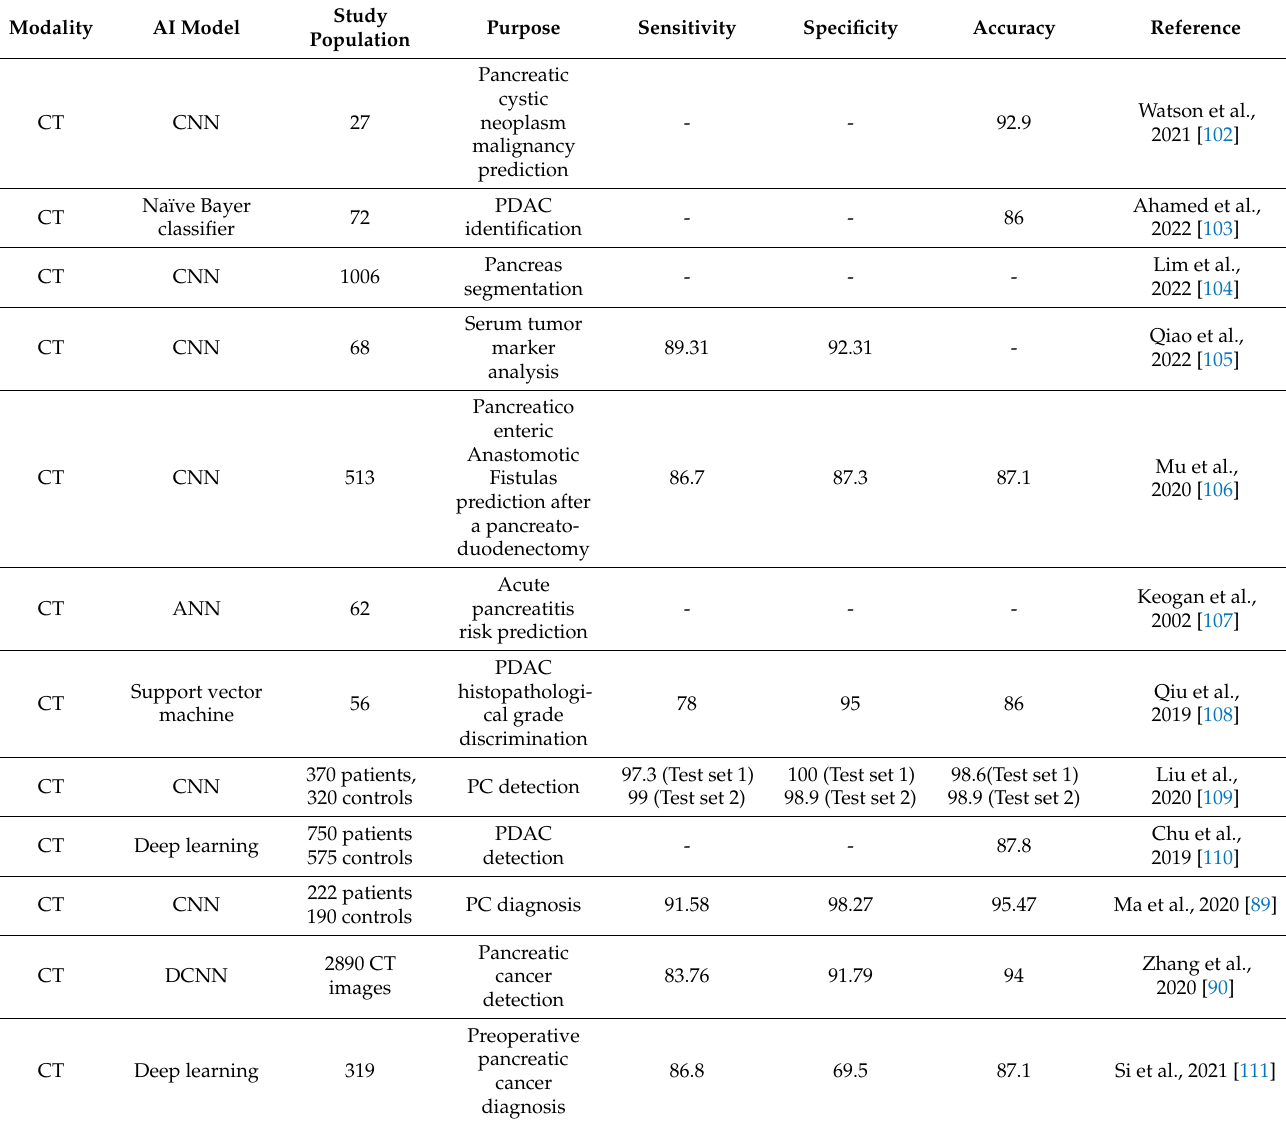
Table 2. Summary of the AI driven models for the pancreatic cancer